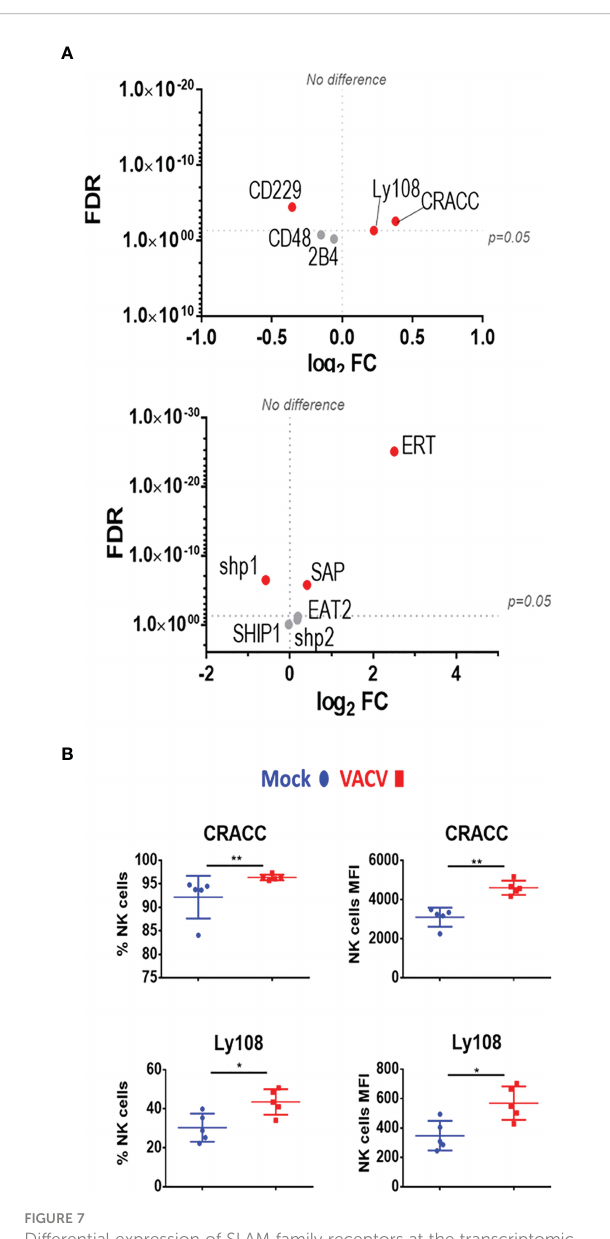
FIGURE 7 Differential expression of SLAM family receptors at the transcriptomic and proteomic levels in NK cells during VACV infection. (A) C57BL/6 mice (n=4) were infected with VACV WT or were mock-infected. At 6.5 d.p.i., NK cell transcriptional changes were studied by RNA-seq (n=4), and differential expression (VACV vs mock) was calculated. Each dot represents the differential expression pro fi le of a SLAM family receptor or adaptor protein transcript (WT vs mock). Red indicates statistical signi fi cance (FDR<0.05). For clarity, the protein name is indicated rather than gene name. (B) Protein expression assessed by FACS for SLAM receptors in splenic NK cells from mock (blue) and VACV-infected mice (red). The percentage of NK cells expressing the receptor and MFI for the indicated receptor is shown. Error bars represent ± SD, statistical signi fi cance was assessed with a Mann- Whitney test (*p < 0.05, **p <